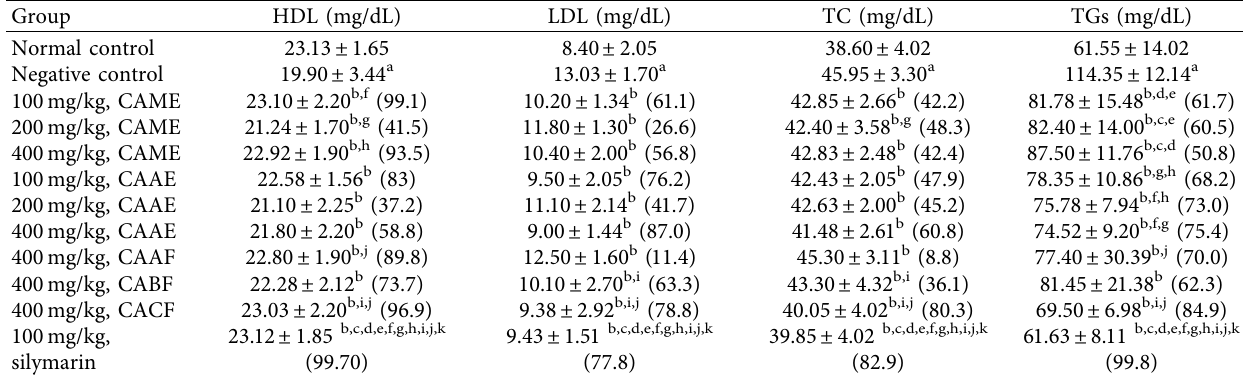
Table 3: Effects of crude extracts and solvent fractions of the 80% methanol extract of C. africana stem bark on lipid profiles of rats orally administered 2g/kg APAP (mean ±